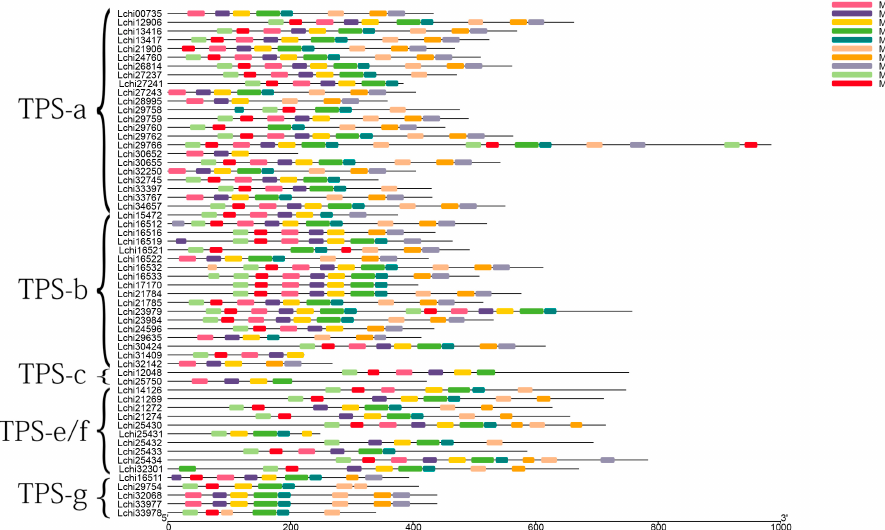
Figure 2. Conserved protein motifs from L. chinense . The numbers 1–10 of motif composition are displayed in di ff erent colored boxes in the LcTPS proteins.